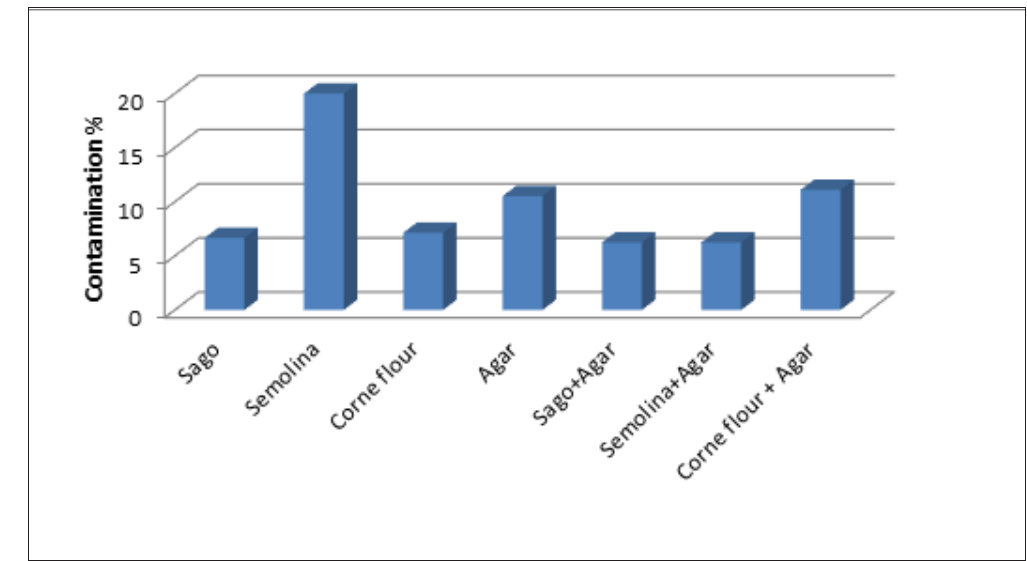
Figure 4 - Contamination percentage of different gelling agents in KNC